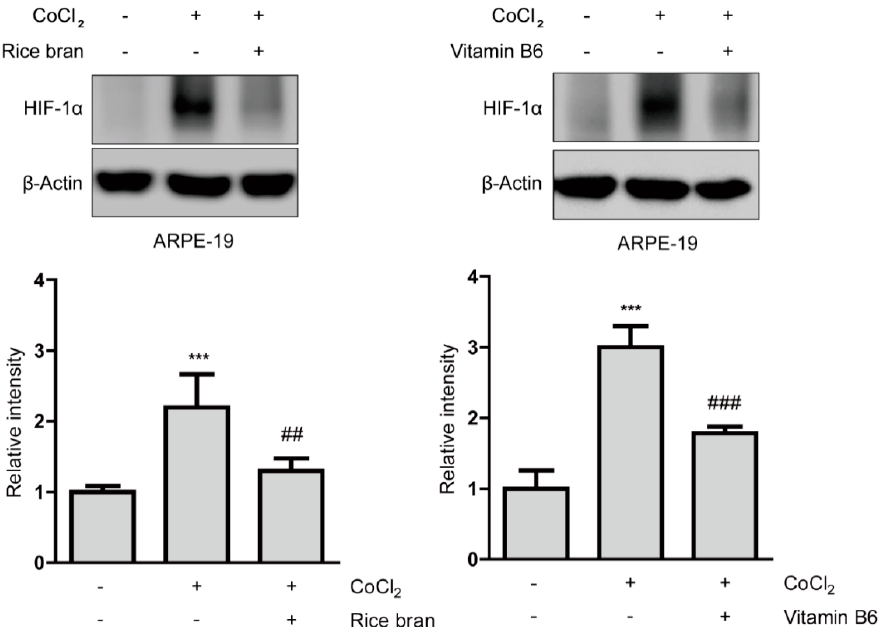
Figure 2. Suppressive effects of rice bran and vitamin B6 on HIF ‐ 1 α stabilization. Representative immunoblot images and quantitative analyses (n = 4 per group) for HIF ‐ 1 α and β‐ Actin showed that HIF ‐ 1 α was stabilized in ARPE ‐ 19 cells under a CoCl 2 ‐ induced pseudo ‐ hypoxic condition. Rice bran (1 mg/mL) and vitamin B6 (1 mg/mL) significantly decreased stabilized HIF ‐ 1 α expression. *** p < 0.001, compared with no treatment, ## p < 0.01, ### p < 0.001, compared with CoCl 2 treatment. Bar